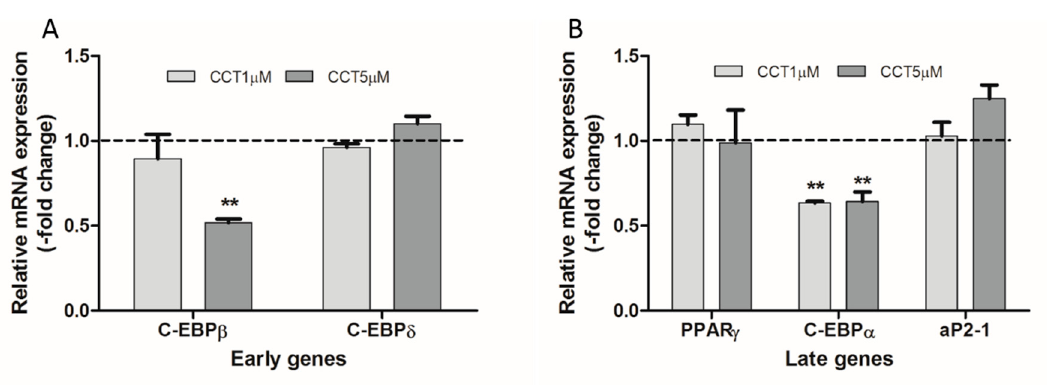
Figure 5. Effect of CCT on messenger RNA (mRNA) expression levels of genes regulating the adipogenic process. The relative quantitative real-time PCR (qRT-PCR) values were corrected to actin expression levels and normalized to control differentiation (0 μ M CCT). Data were obtained from three independent experiments and are expressed as the mean ± SD. The maximum mRNA expression level for 0 μ M CCT was set to 1 (dashed line); the relative mRNA expression levels obtained with the two CCT concentrations (1 and 5 μ M) at the same time-point are depicted. ( A ) Cells were collected at the ID-time-point for the expression of early genes, CCAAT/enhancer-binding protein ( C/ EBP) β and C/EBP δ , evaluated using qRT-PCR with specific primer pairs. ( B ) Cells were collected at the FD time-point for the expression of late genes, peroxisome proliferator-activated receptor γ ( PPAR γ ) and C/ EBP α , evaluated using qRT-PCR with specific primer pairs; the expression of aP2-1 (as a specific adipocyte marker) was also evaluated. ** indicates a significant difference compared with control differentiated cells ( p < 0.01).